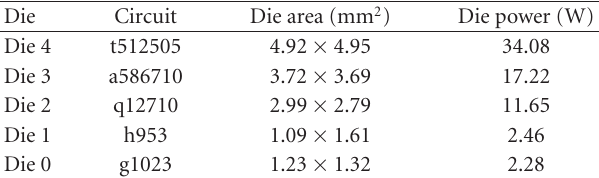
Table 3: The third test